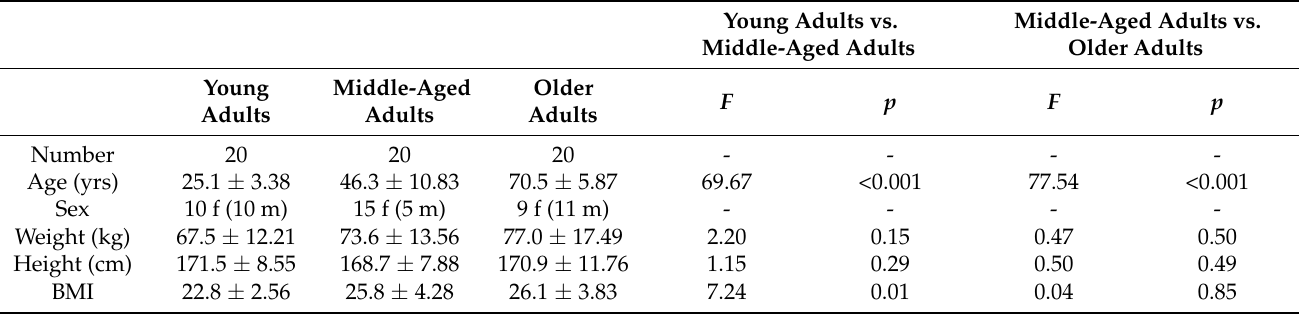
Table 1. Groupwise participant characteristics and demographics. f -statistics ( F ) and p -values ( p ) are reported for each group comparison. Where applicable, corresponding data is presented as means ± SD. BMI—Body Mass Index.